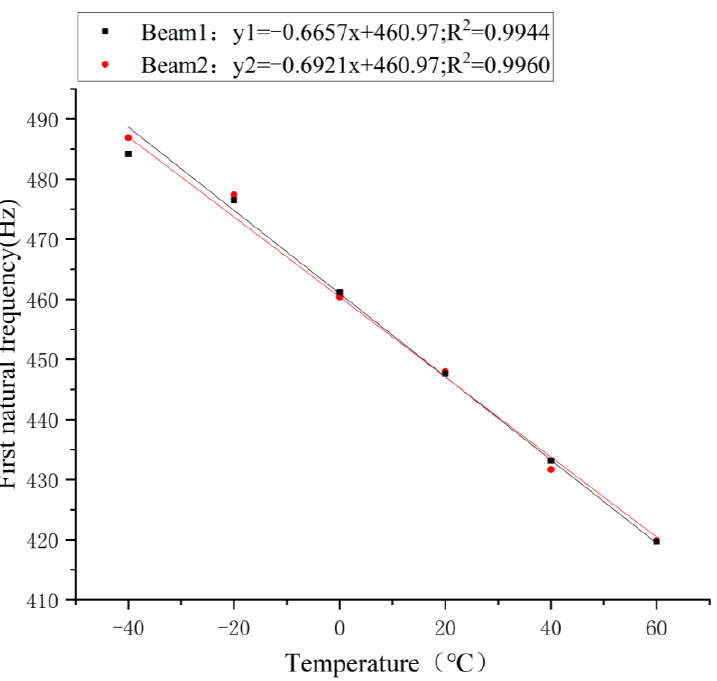
Figure 4. Relationship between the first-grade natural frequency of the No. 1 beam and the No. 2 beam with temperature